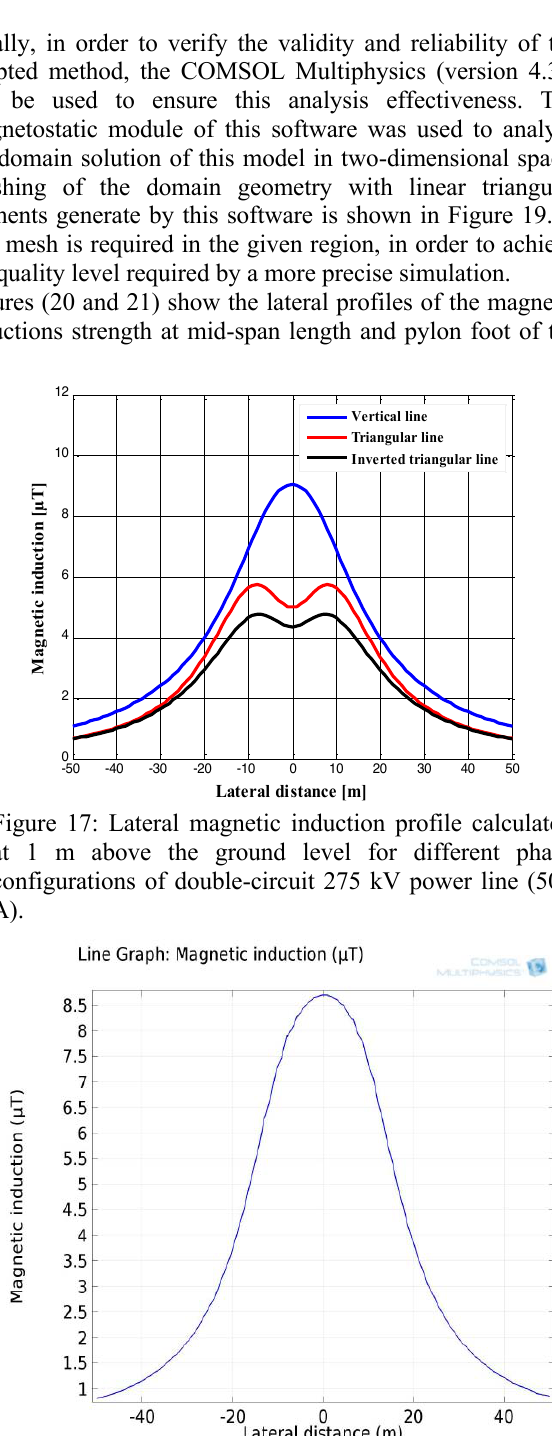
Figure 20: Magnetic induction profile at mid-span length at 1 m above ground level using COMSOL 4.3a